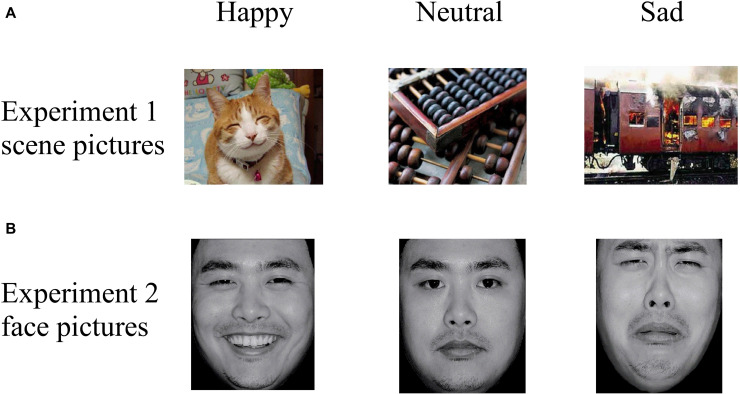
Examples of stimuli in (A) Experiment 1 and (B) Experiment 2, with examples of happy (left column), neutral (middle column), and sad (right column) pictures. Pictures were selected from the CAPS and the CFAPS that have been previously validated and used in published studies (Bai et al., 2005; Gong et al., 2011; Ma and Zhu, 2014; Wang et al., 2017).